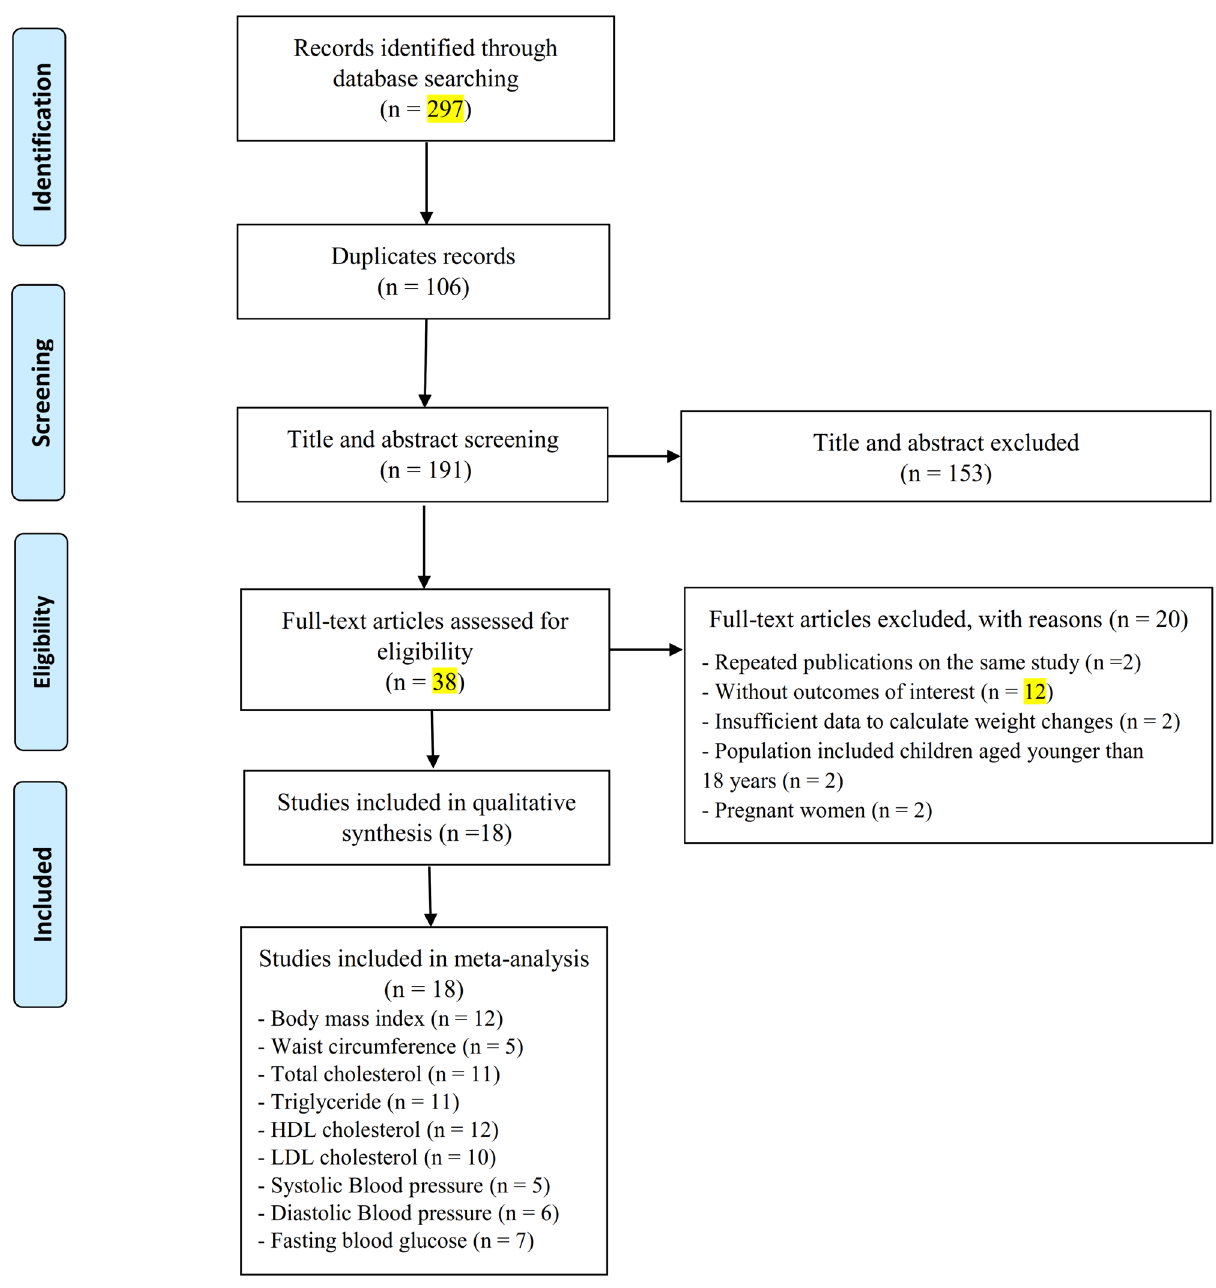
Figure 1. Flow diagram for the study selection